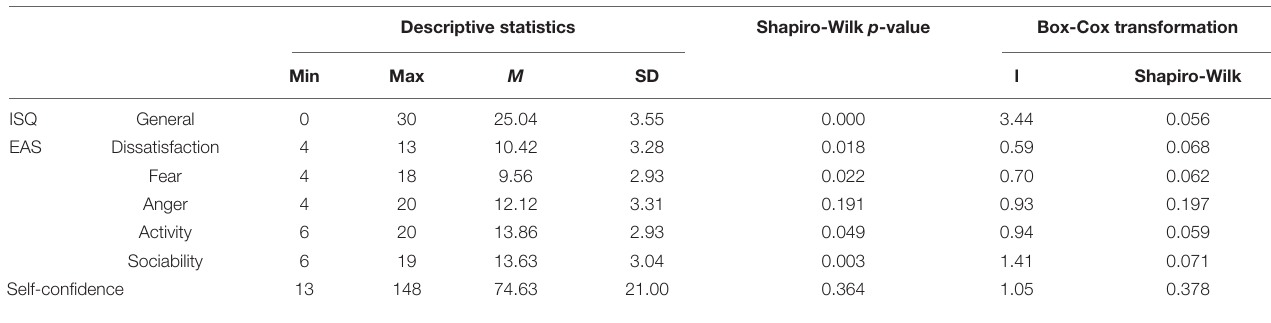
TABLE 1 | Descriptive statistics and Shapiro–Wilk’s test of normality in collected